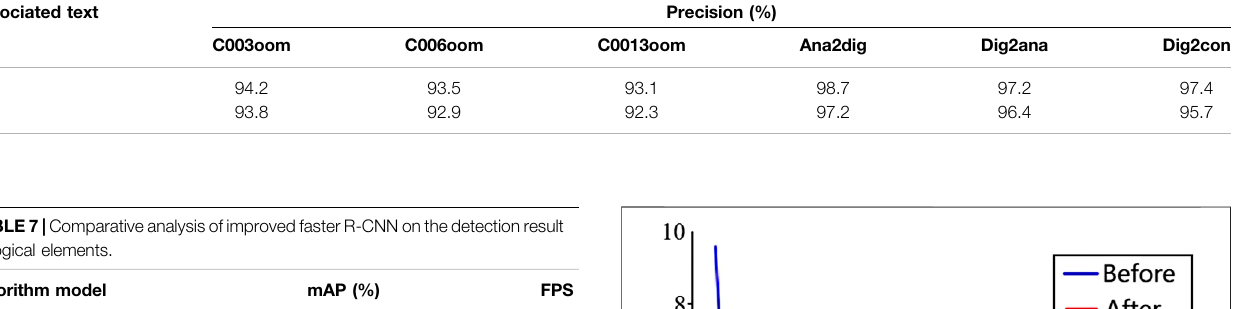
TABLE 6 | Associated text intrinsic property validation for logical element recognition. Associated text